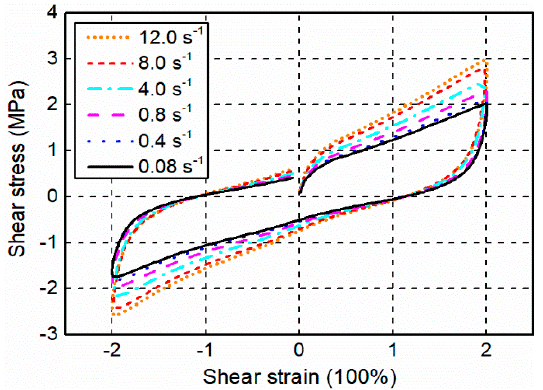
Figure 10. Measured stress–strain responses in the cyclic shear tests.